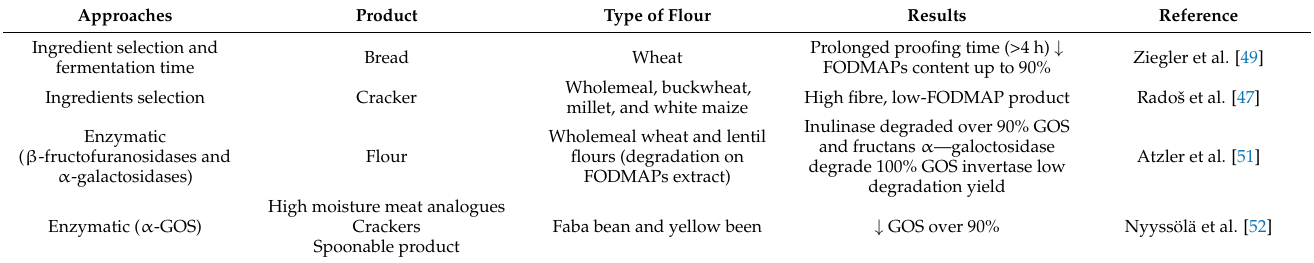
Table 3. Effect of the use of different approaches for the reduction of FODMAPs content in cereal and legumes flours, bread, and other cereal- and legume-based